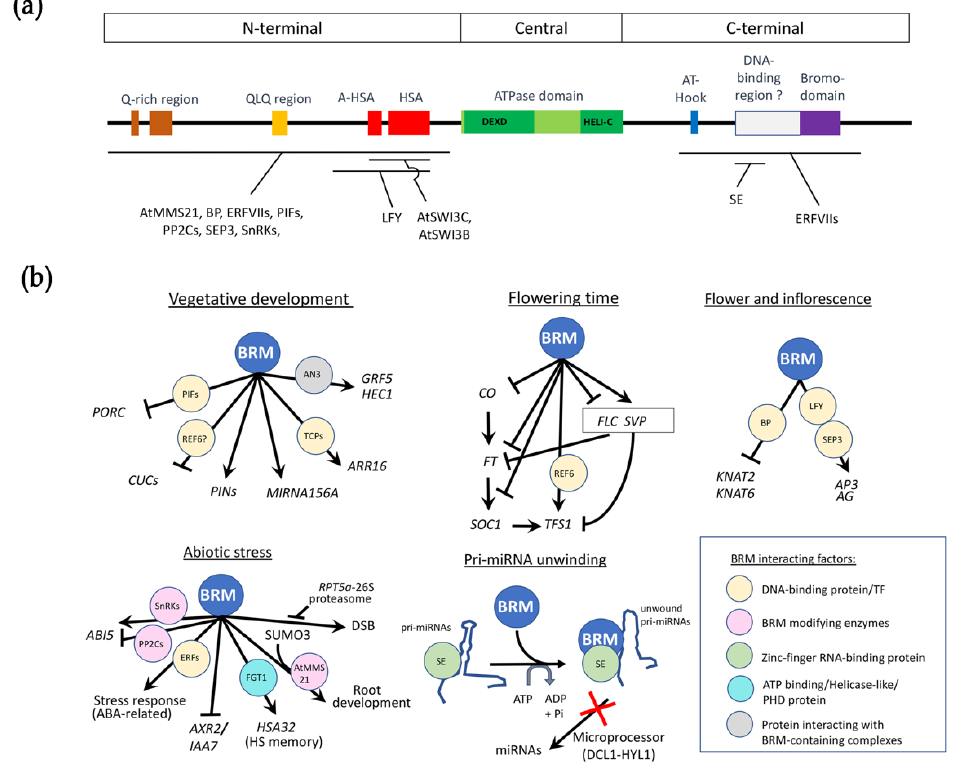
Figure 1. BRM domains and BRM roles in plant development. ( a ) Schematic representation of BRM domain compositions and regions that its partners interact. Partners that interact with BRM are shown below; ( b ) Overview of the main BRM roles in plant development. Gene regulations by BRM are shown by hammerhead arrows and pointed arrows, representing repression and activation, respectively. Direct interactors of BRM are presented by circles with color background according to 5 types and described in the inset. ANGUSTIFOLIA3 (AN3) may not interact directly with BRM as a direct interaction has not been reported in the literature. Core SWI / SNF subunits SWI3A, B and C that interact physically with BRM are described in [5].